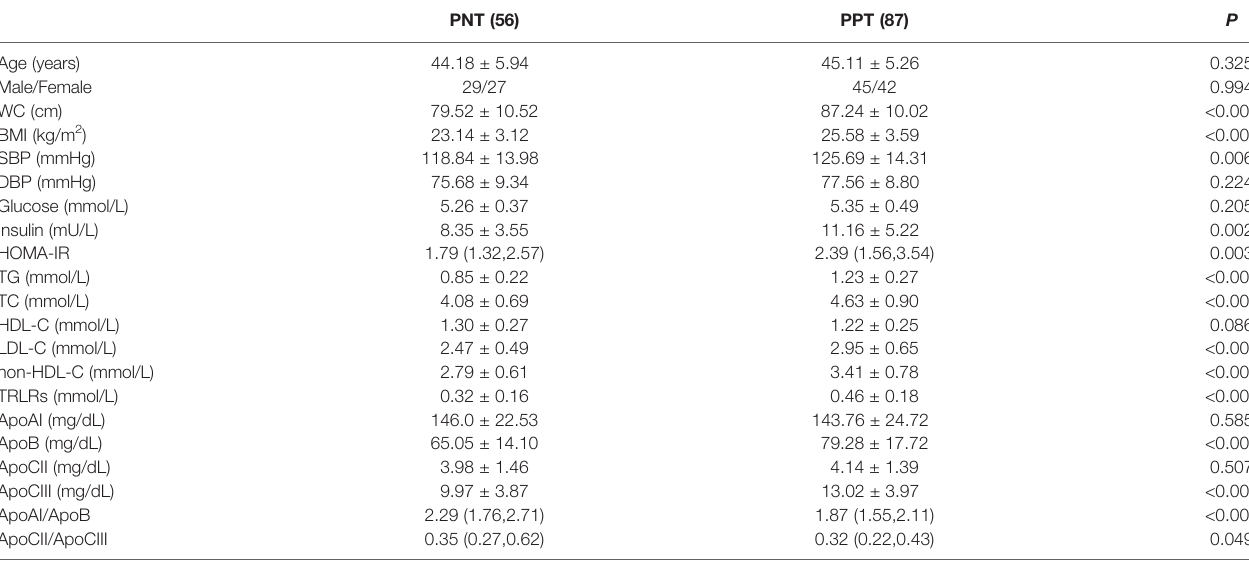
TABLE 1 | Anthropometric and fasting metabolic parameters in the two